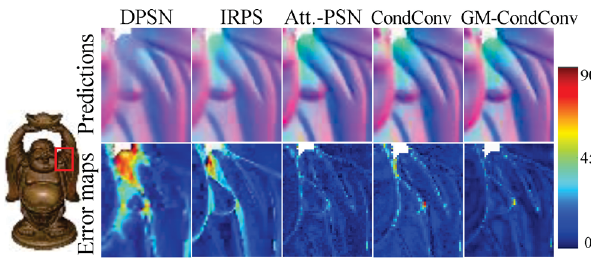
Fig. 2 An enlargement from “Buddha” from the DiLiGenT dataset [19]. Att.-PSN: Attention-PSN. CondConv represents using the